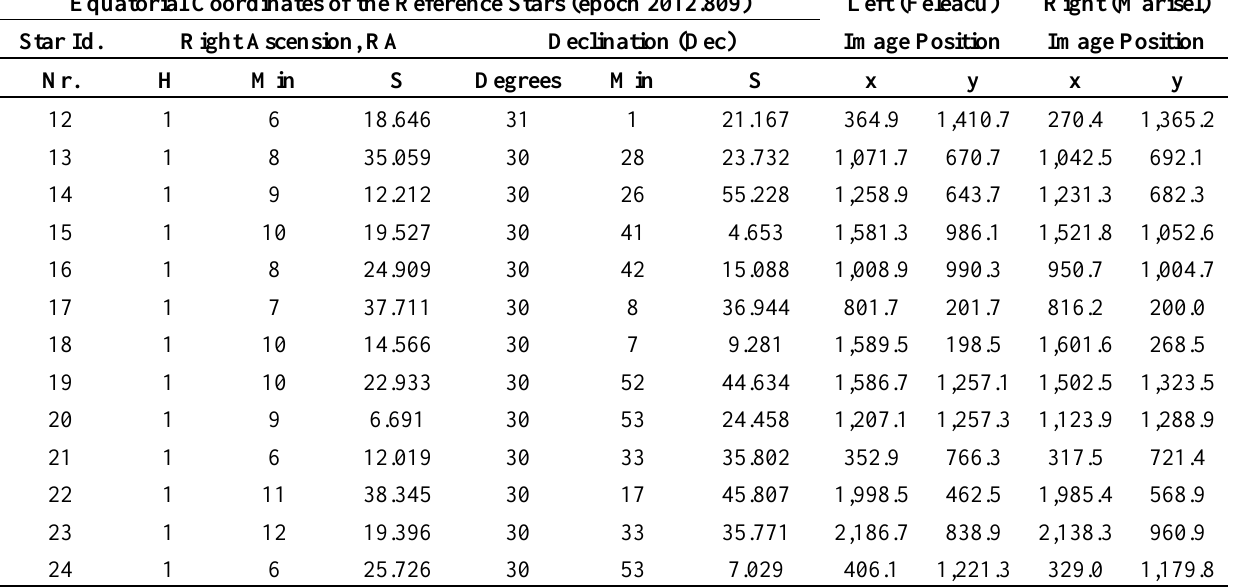
Equatorial Coordinates of the Reference Stars (epoch 2012.809)